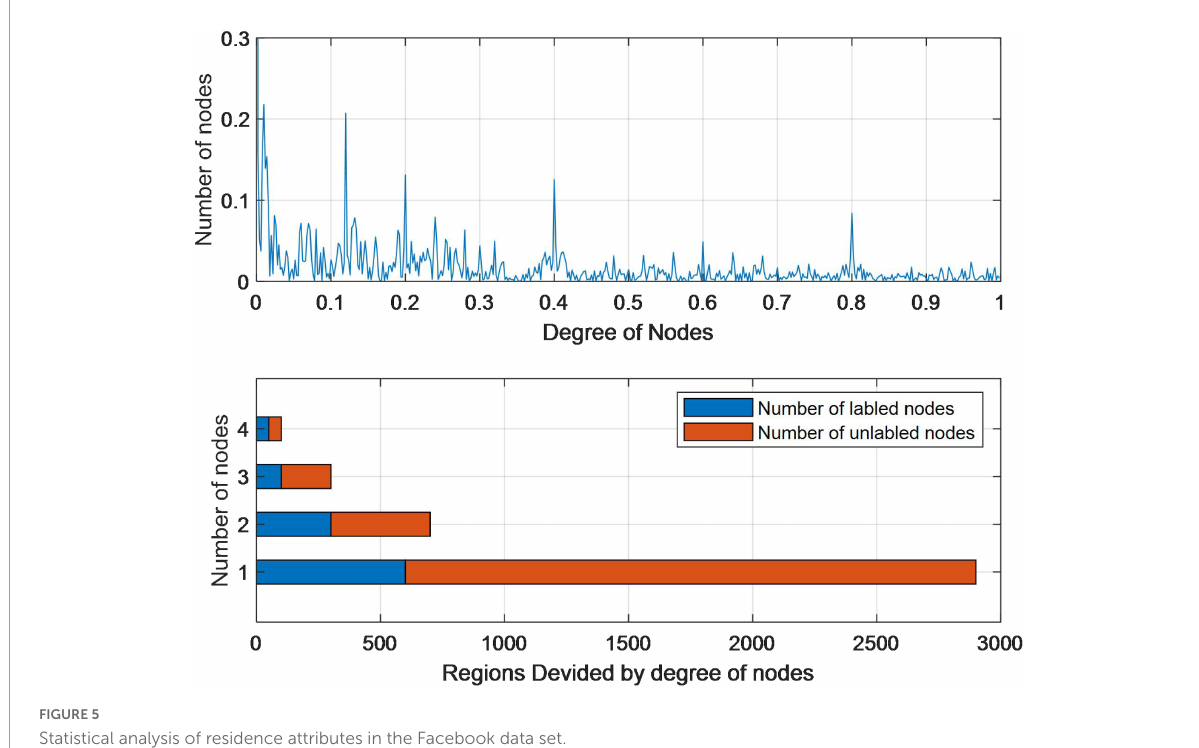
FIGURE5 Statistical analysis of residence attributes in the Facebook data set.